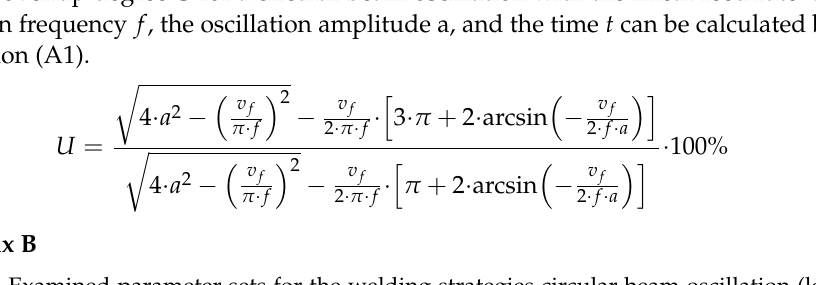
Table A1. Examined parameter sets for the welding strategies circular beam oscillation (left and center) and vertical eight beam oscillation (right); reference parameter sets marked in